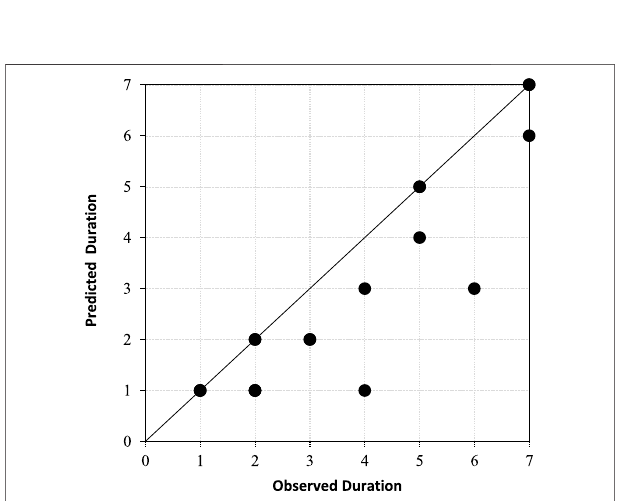
FIGURE 11 | Comparison between observed and predicted drought duration.